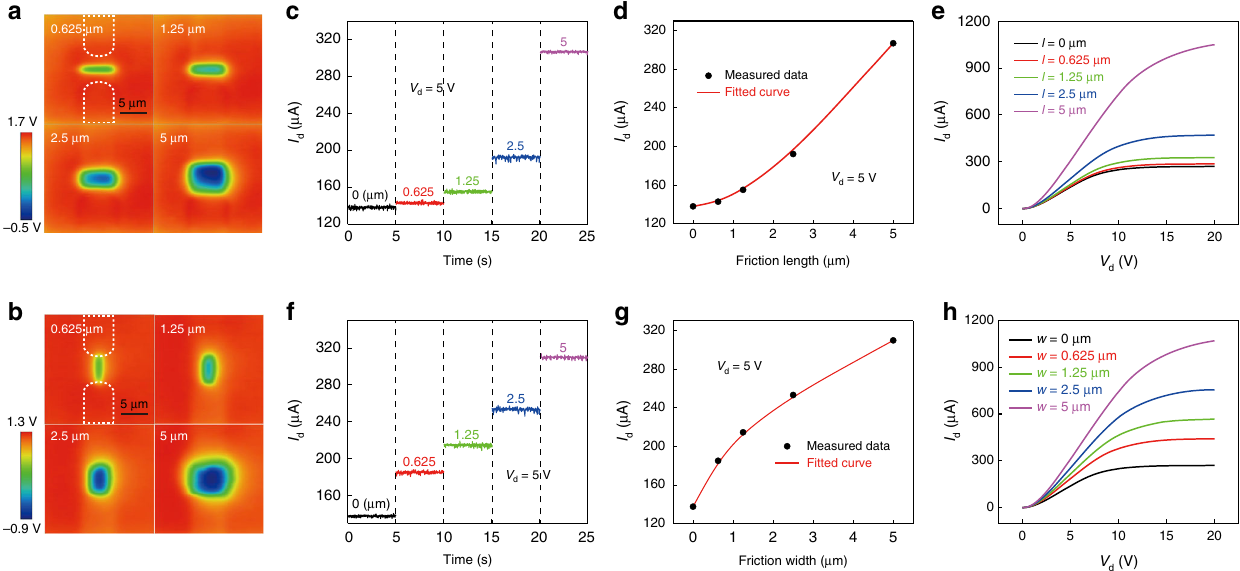
Fig. 3 The effect of the contact region on the characteristics of the NTT. Surface potential distributions of the NTT after regionally rubbed by the AFM tip with the increasing ( a ) length and ( b ) width. c I d output characterisics at a drain voltage of 5 V with different contact lengths from 0.625 μ m to 5 μ m. d The I – l transfer characteristics. e I – V I d d d output characteristics with the different contact lengths. f d output characterisics at a drain voltage of 5 V with different contact widths from 0.625 μ m to 5 μ m. g The I d – w transfer characteristics. h I d – V d output characteristics with different contact concentration in valence band and drain current of the NTT. On low as the highest fi lled surface states of SiO 2 . At this condition, the contrary, a positive tip voltage can lower the Fermi level of the no charge can fl ow between the AFM tip and the top SiO 2 surface. When the tip voltage is more positive than the nulli fi ed voltage Si probe, reducing the number of electrons fl owed from the AFM ( V T > V N ), electrons can fl ow reversely from the top SiO 2 surface tip to the top SiO 2 surface. As the positive tip voltage increases to a certain value ( V T = V N ), the Fermi level of Si probe can be as to the AFM tip. Therefore, a positive built-in electric fi eld is